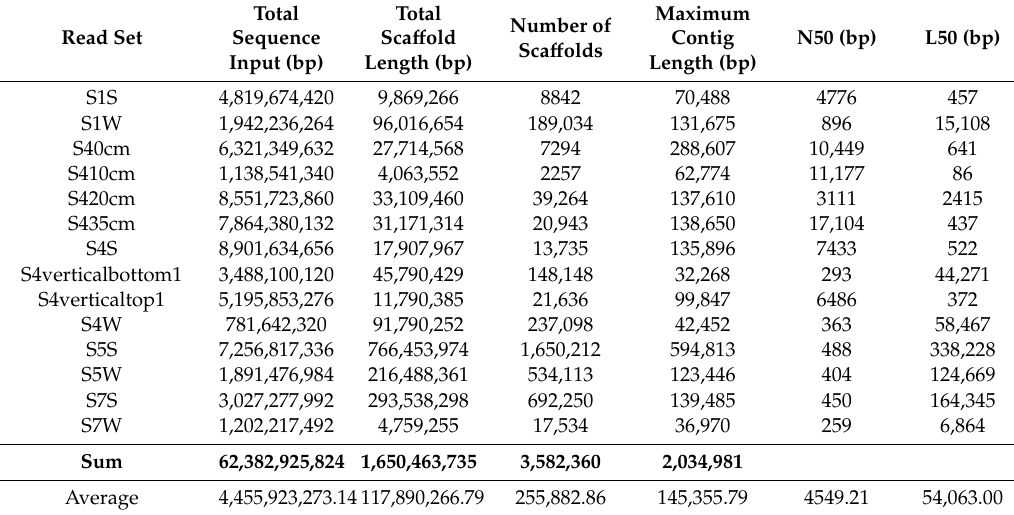
Table 1. Metagenomic assembly statistics for Calumet read sets.